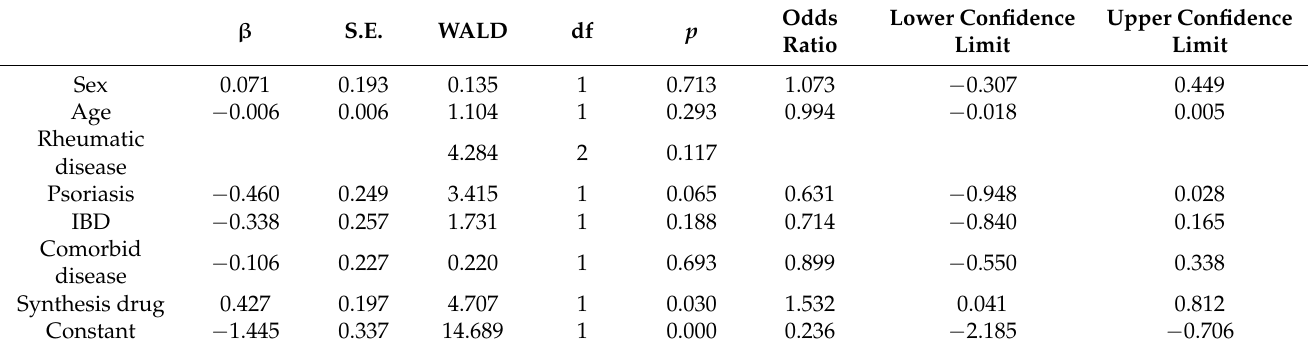
Table 4. Logistic model with dependent variable ‘COVID-19